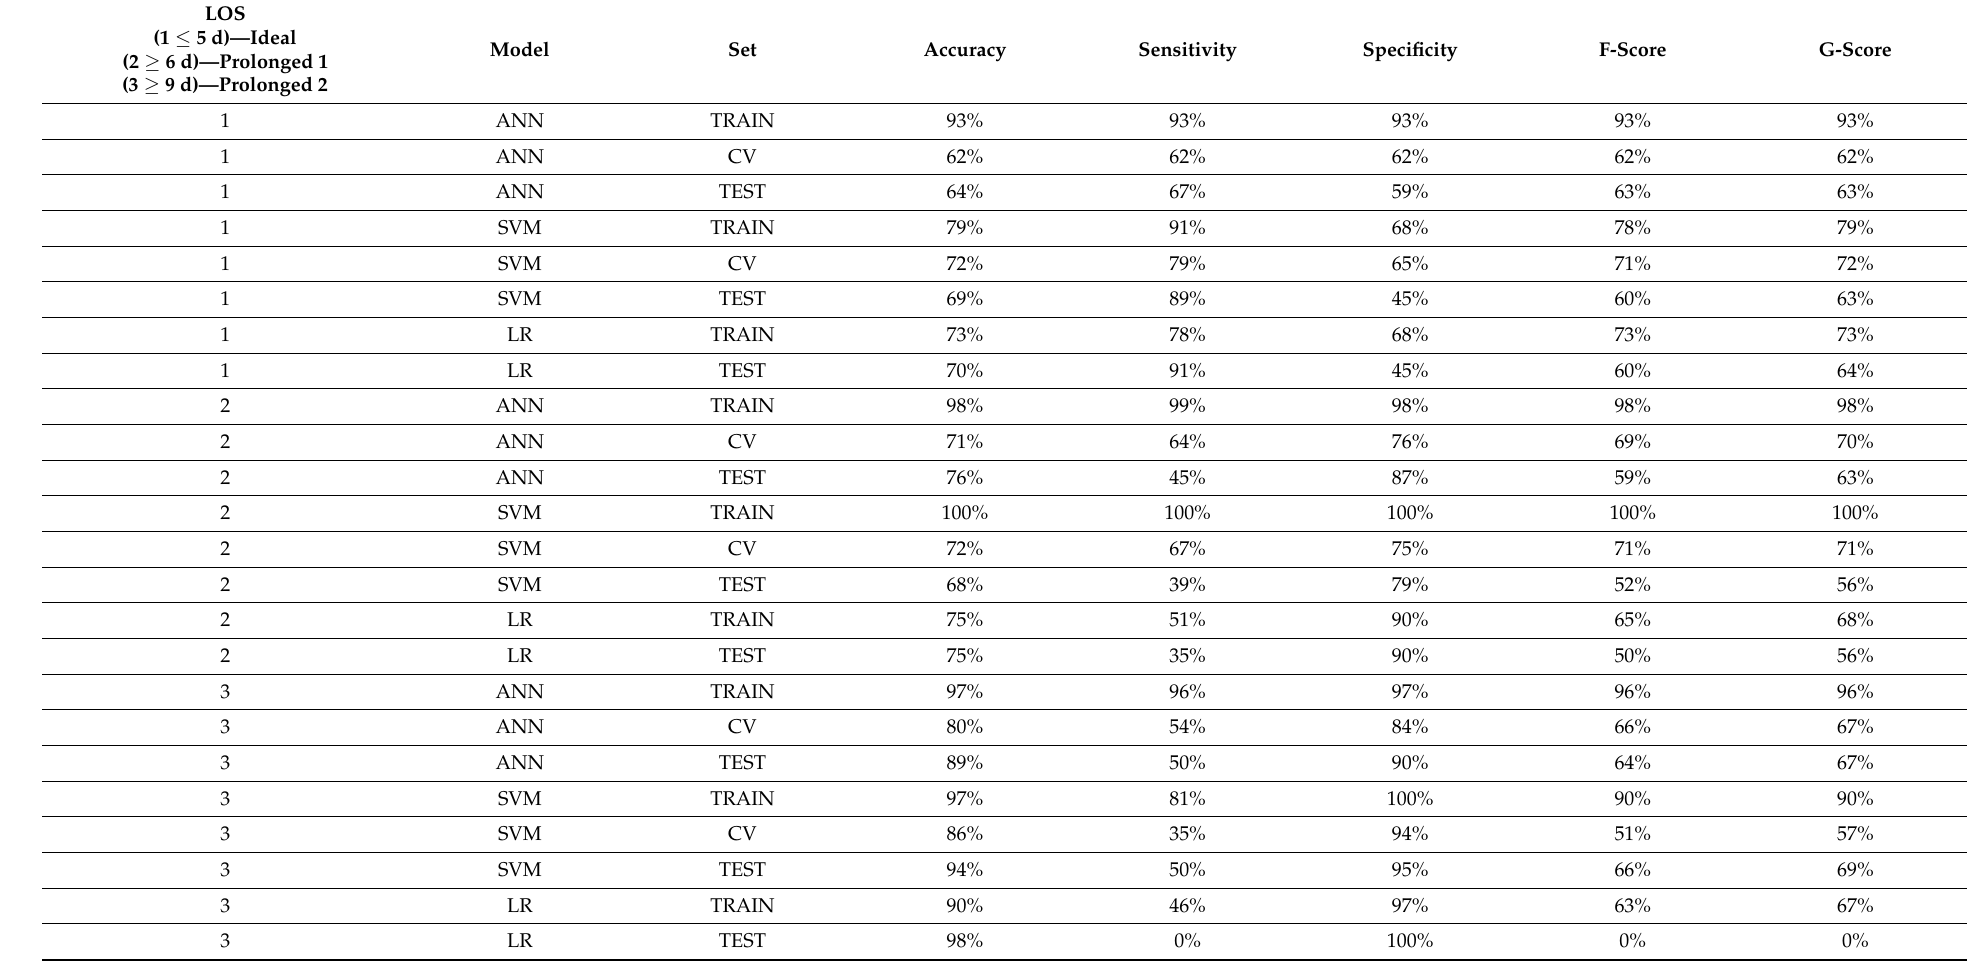
Table 3. Prediction performance of the three models for (1) ideal (2) prolonged 1; (above median) (3) prolonged 2; (above 90th centile) length of stay